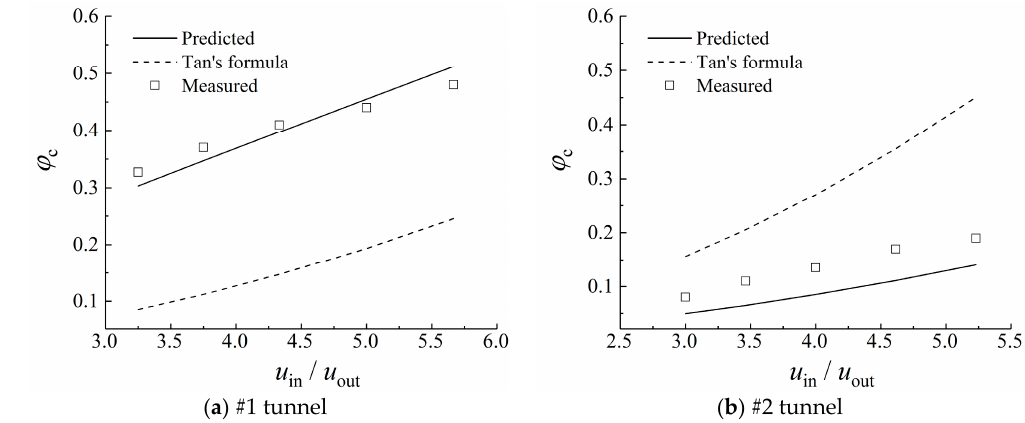
Figure 17. Comparison of predicted circulating air mixing ratio φ c with measured results.